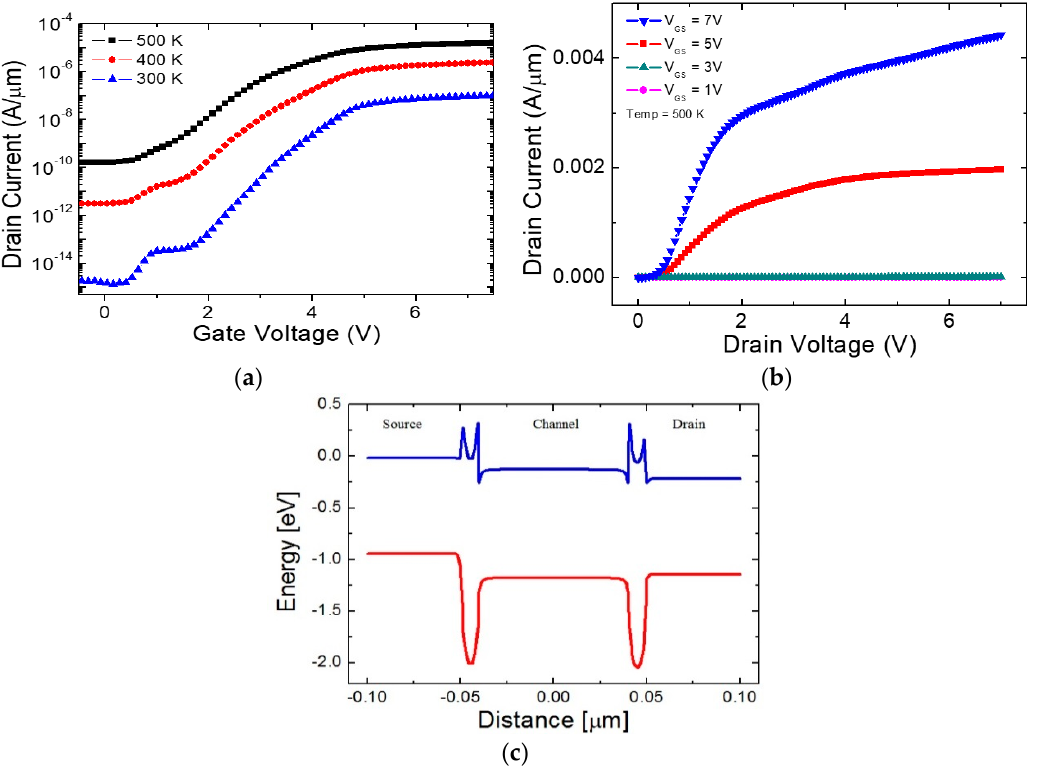
Figure 2. Operation characteristics. ( a ) I D -V GS characteristic curves with V DS = 0.2 V at 300 K, 400 K, and 500 K; ( b ) I D -V DS characteristic curves at different V GS values at 500 K; ( c ) energy-band diagram along the channel beneath the gate oxide at V GS = 8 V and V DS = 0.2 V at 500 K.